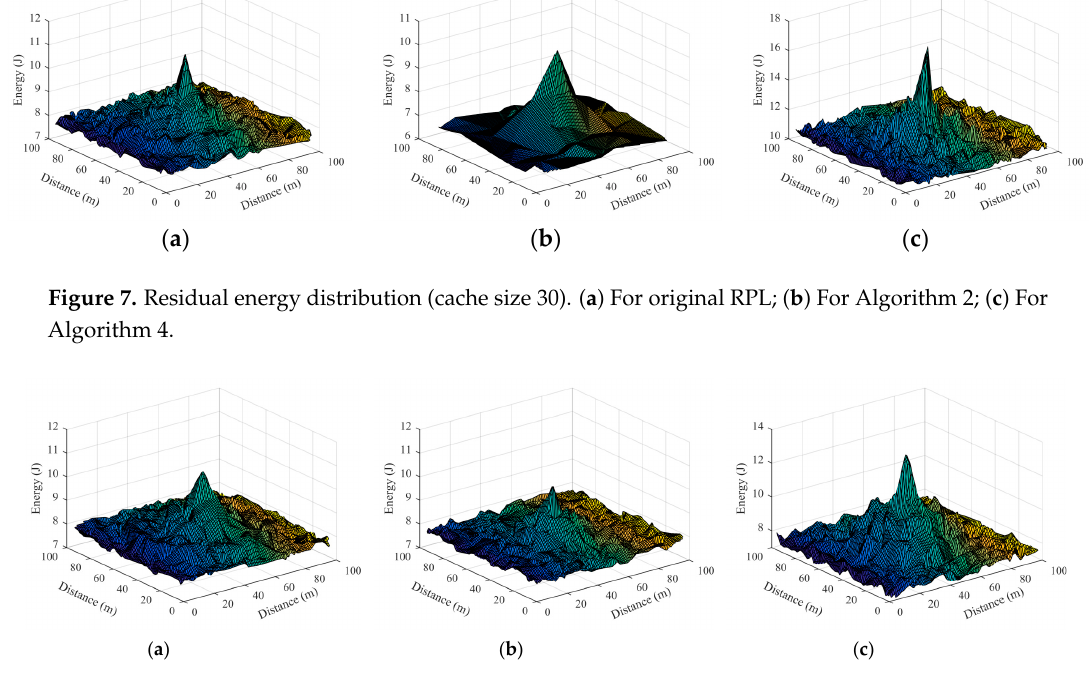
Figure 8. Residual energy distribution (cache size 50). ( a ) For original RPL; ( b ) For Algorithm 2; ( c ) For Algorithm 4.